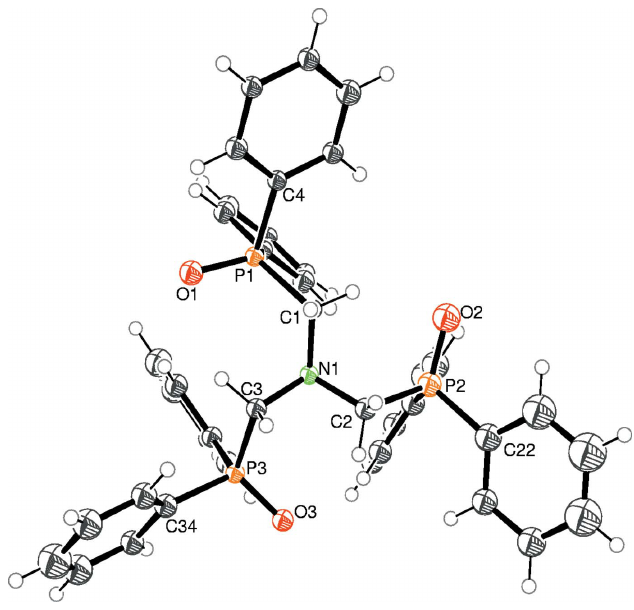
Figure 2 View along the pseudo-threefold rotation axis of one of the N , N , N - tris(diphenylphosphorylmethyl)amine molecules present in the asym- metric unit. Displacement ellipsoids are drawn at the 50% probability